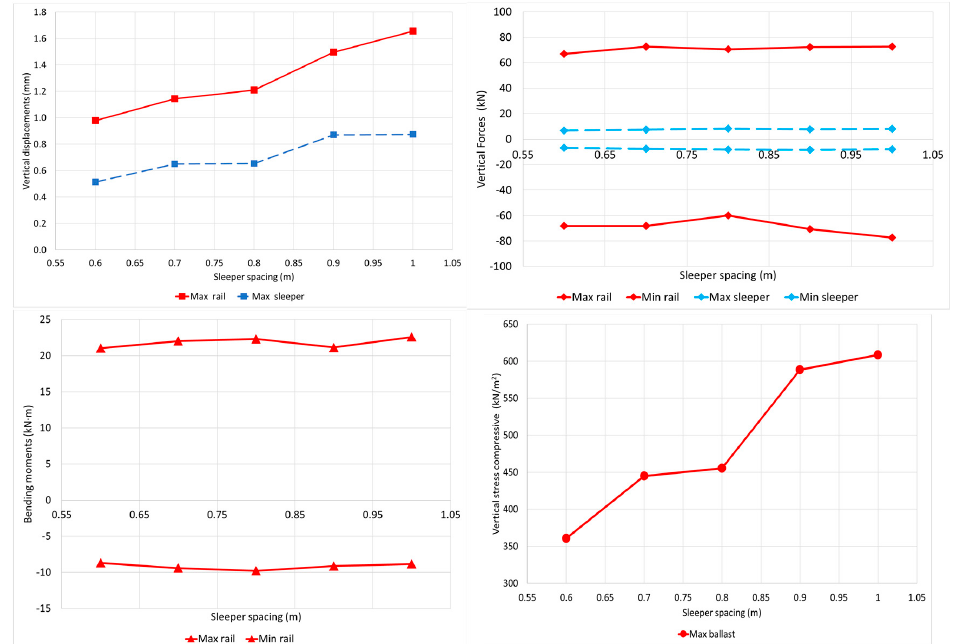
Figure 3. Case 1. From left to right, and from top to bottom. Maximum vertical displacements of the rail and sleeper, vertical forces on rail and sleeper, rail bending moments, and stresses on ballast.